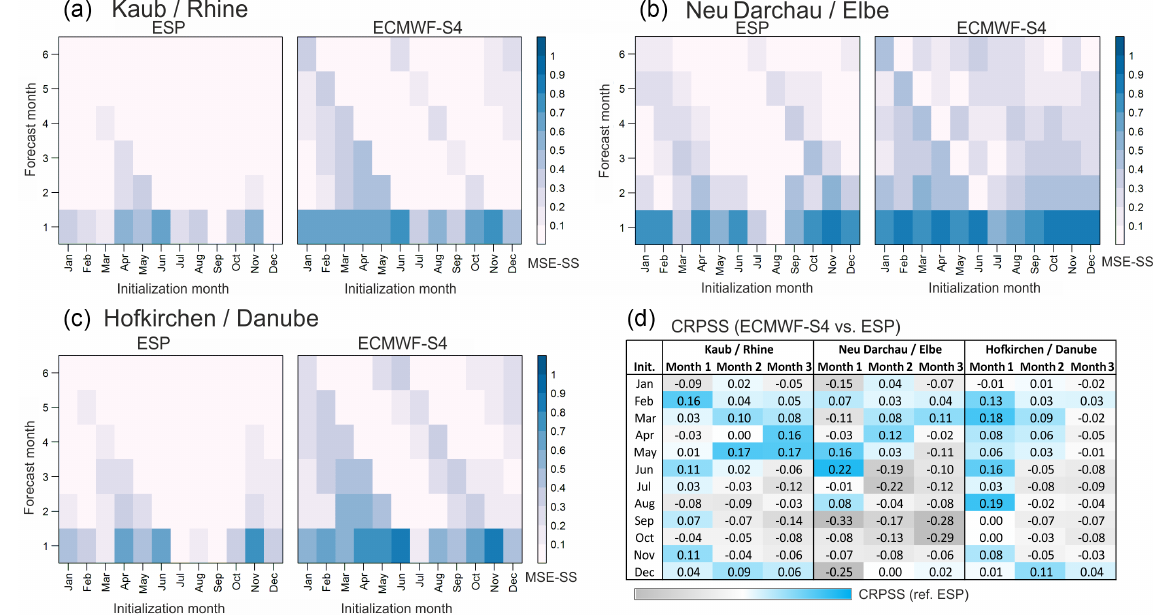
Figure 6. MSE-SS for ESP and S4-driven forecast for each initialization and forecast month at the stations Kaub/Rhine (a) , Neu Darchau/Elbe (b) , Hofkirchen/Danube (c) and CRPSS values of S4-driven forecast related to ESP for forecast months 1 to 3 (verification period 1981– 2014) (d)